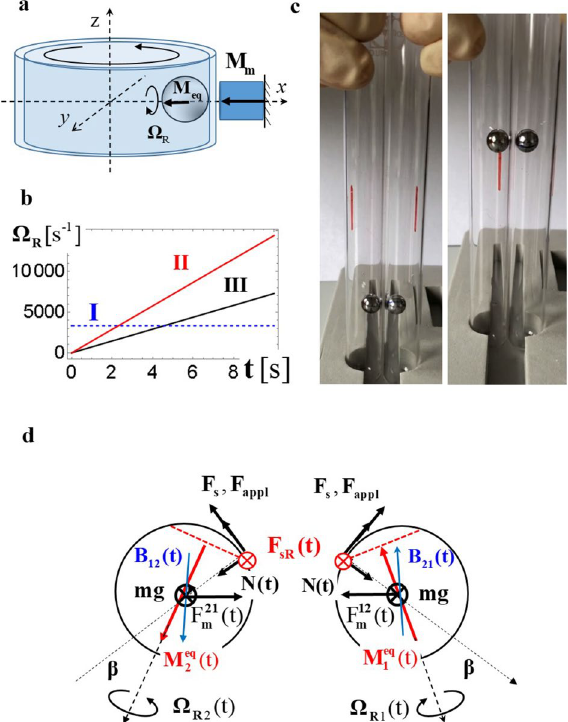
Figure 3. Different embodiments of the spin revolution. ( a ) Reciprocal embodiment leading to revolution of a sphere without its lateral displacement. Reprinted with permission from 11 ; ( b ) Numerically calculated (cid:31) R for a NiCoB sphere with m = 3 · 10 − 4 kg, R = 3 · 10 − 3 m and M s = 0.5 A · m 2 , and friction coefficient k = 0.1 for I embodiment of ( a ) with v = 5 m/s, II rolling down an incline with β = π/ 10 and B = ( − 0.95, − 0.22, 0.22 ) 10 − 5 T; and III rolling down an incline with β = π/ 10 and B = ( 0, 1, 0 ) 10 − 5 T; ( c ) Two subsequent snap-shots of magnetic spheres (NiCoB, m = 5 · 10 − 4 kg, R = 3 · 10 − 3 m and M s = 0.5 A · m 2 ) moving upwards inside of two non-magnetic tubes. ( d ) Top view of the set-up ( c ). Red arrows indicate the magnetic moments, red dashed lines show the rolling planes, red circles indicate the orientation of rolling friction. Blue arrows represent magnetic fields, black arrows show